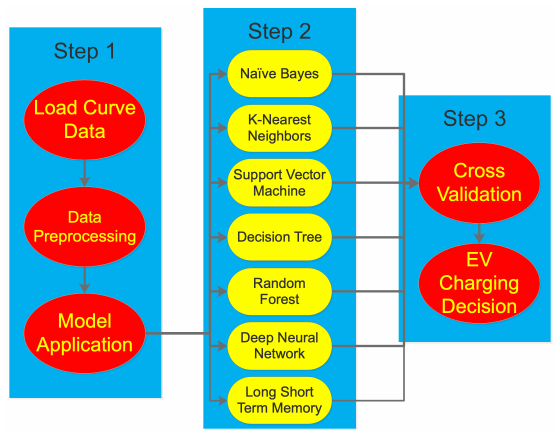
Figure 1. Sequential diagram of the presented experimental